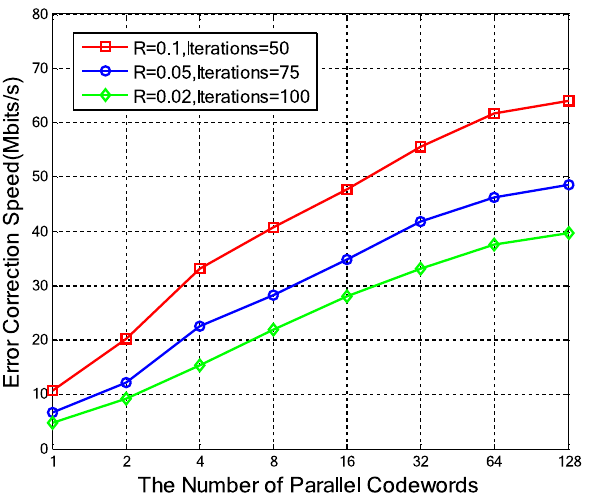
Figure 5. Error correction speed comparison among the different number of decoded codewords in the layered decoder.